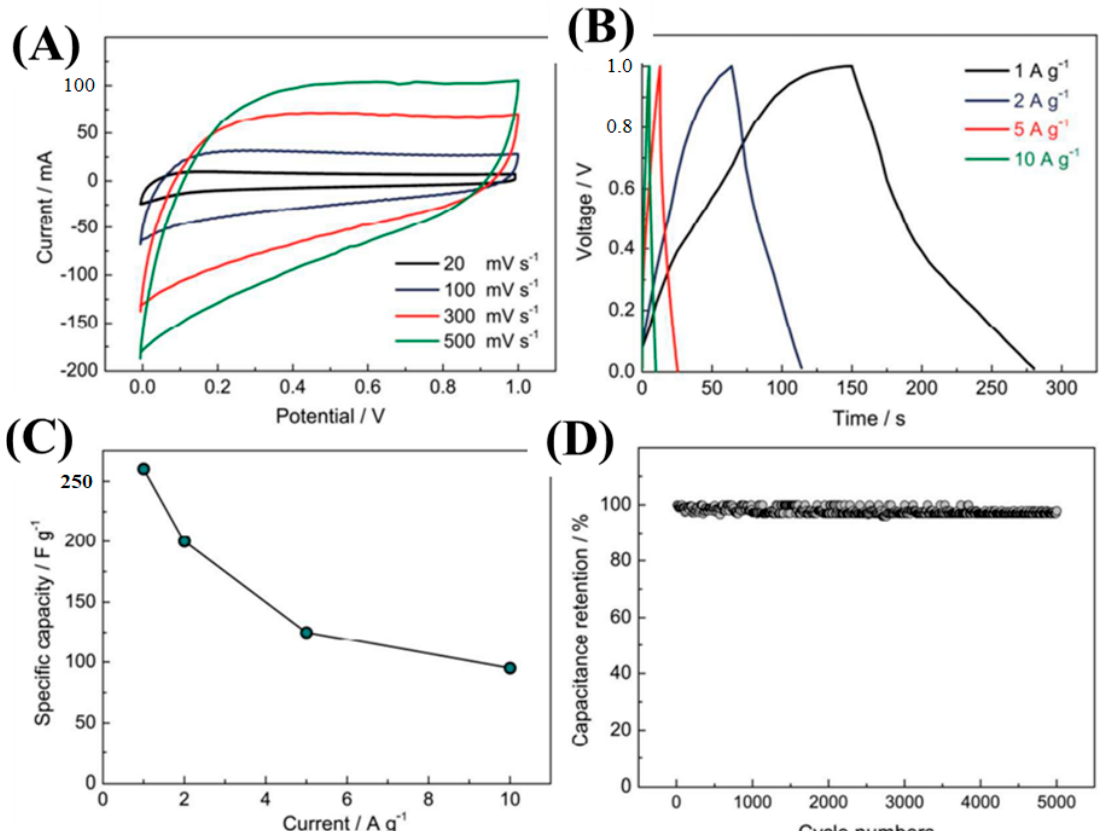
Figure 14. Electrochemical investigations: CV and GCD curves ( A , B ); plot between specific capacity versus current density ( C ); and cyclic durability test ( D ) [117].